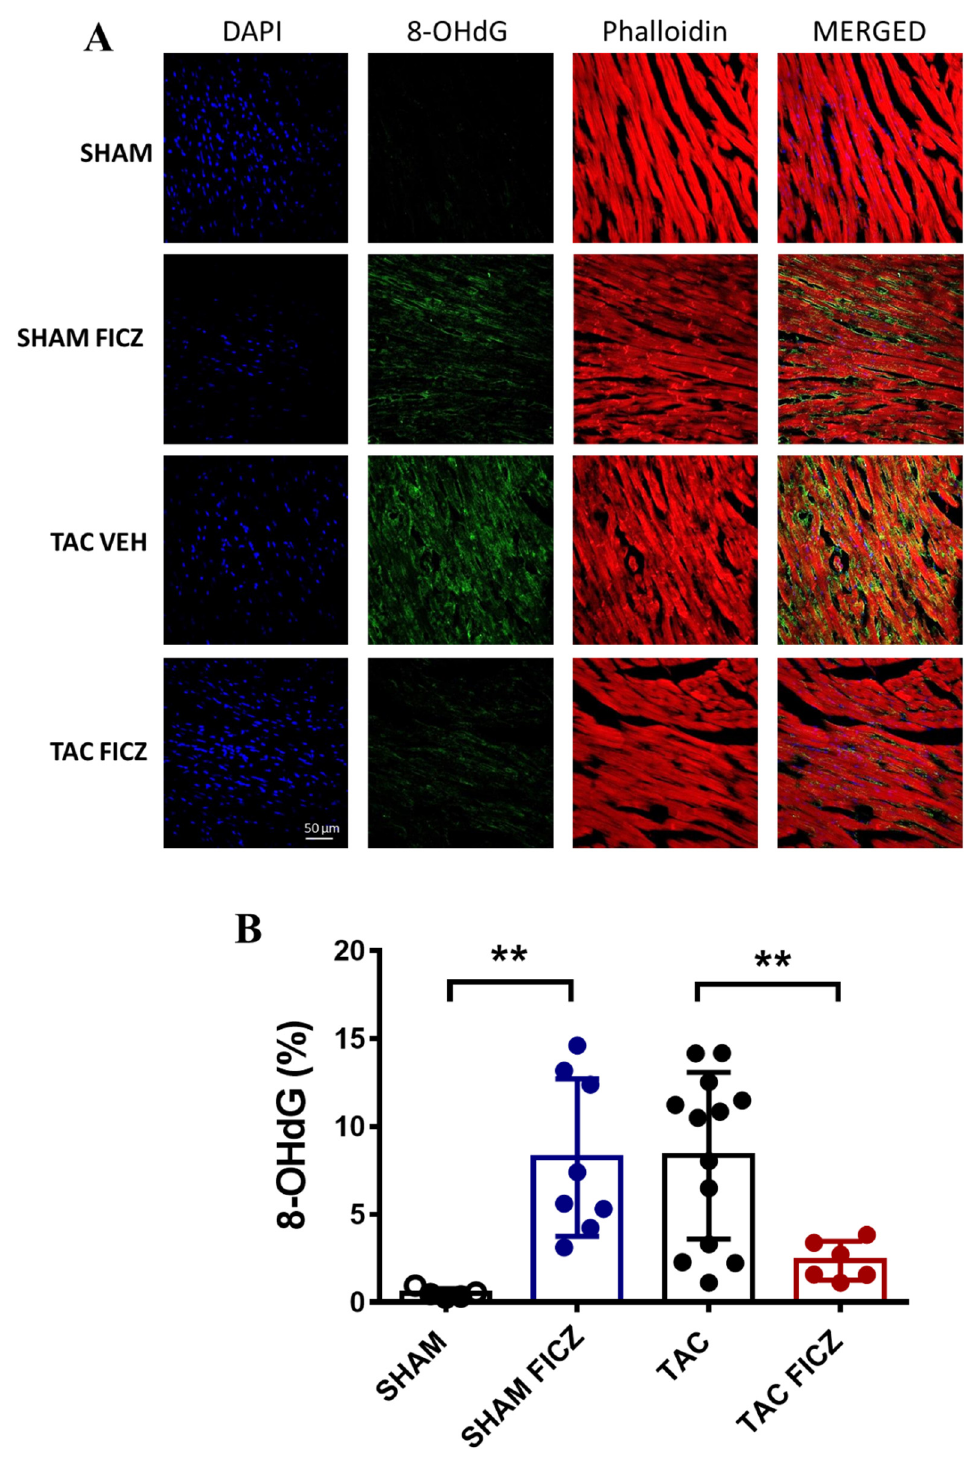
Figure 6. Cardiac staining of 8-hydroxy-2 ′ -deoxyguanosine (8-OHdG) as a biomarker of DNA/RNA damage by oxidative stress: ( A ). Representative examples of immunofluorescent images obtained in all experimental groups. ( B ). Levels of 8-OHdG staining in the four groups of mice. Groups are: Sham (open circles) ( N = 5), Sham FICZ (blue circles) ( N = 8), TAC (black circles) ( N = 13) and TAC FICZ (red circles) ( N = 6). Data are expressed as mean ± SD. ** p < 0.01. There is evidence that AhR engagement can trigger the activation of NRF2, a master regulator of the cellular antioxidant response [19]. To test the possible implication of NRF2